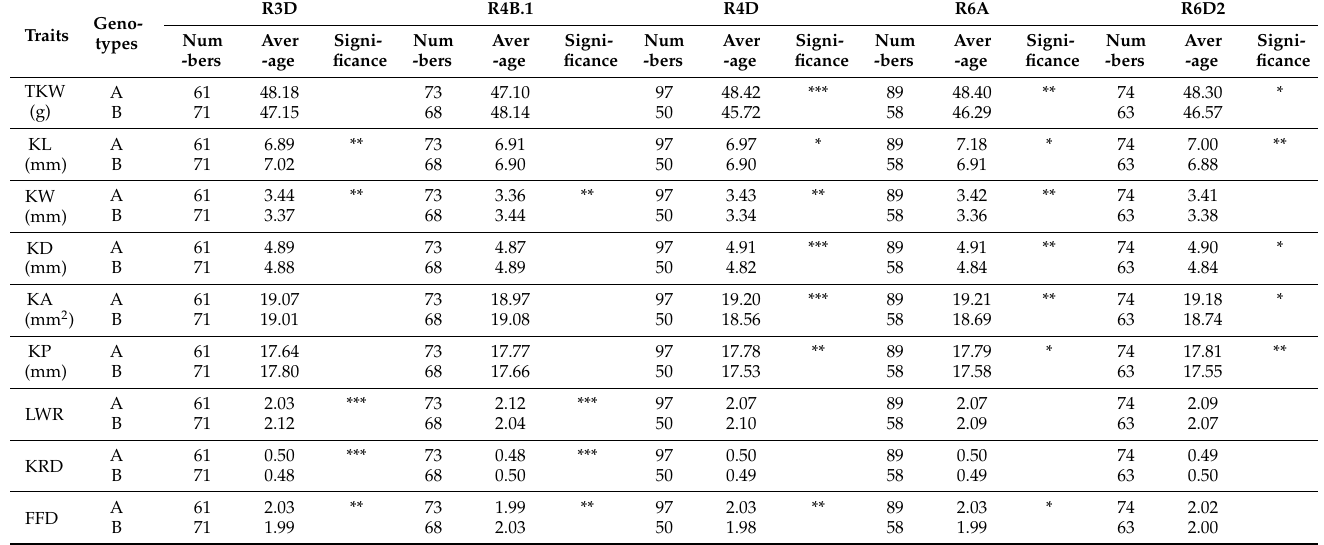
Table 4. The validation of the crucial regions for TKW and kernel-related